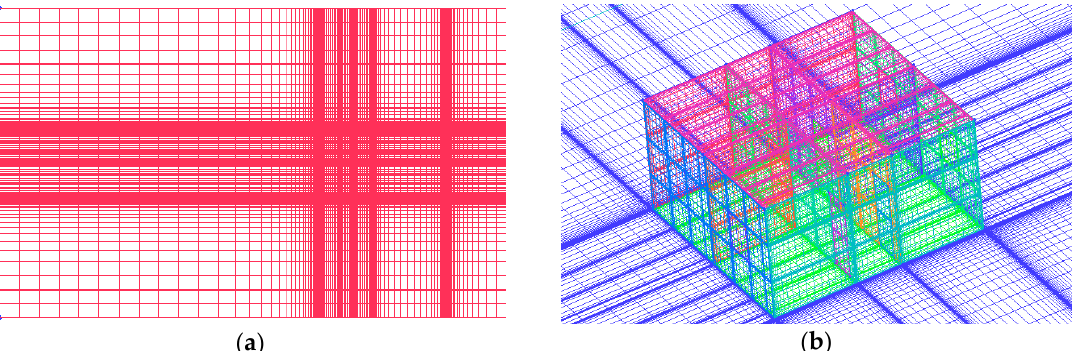
Figure 5. ( a ) The overall grid schematic diagram (top view); ( b ) Local grid schematic diagram of the building surface.